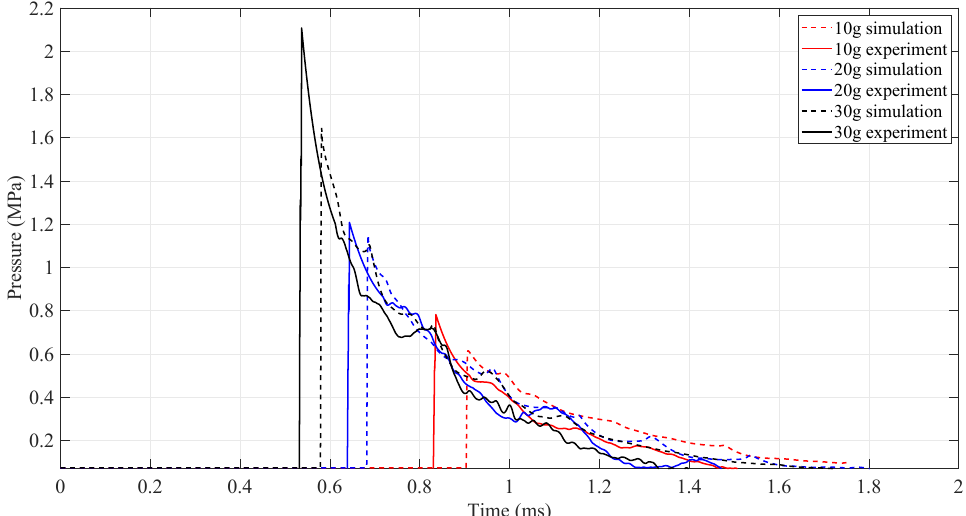
Figure 18. Comparison between experimental and numerical simulation results of the TNT equivalent peak pressures and blast arrival times at 1180 mm from the center of detonation for 10, 20, and 30 g spherical explosive charges.